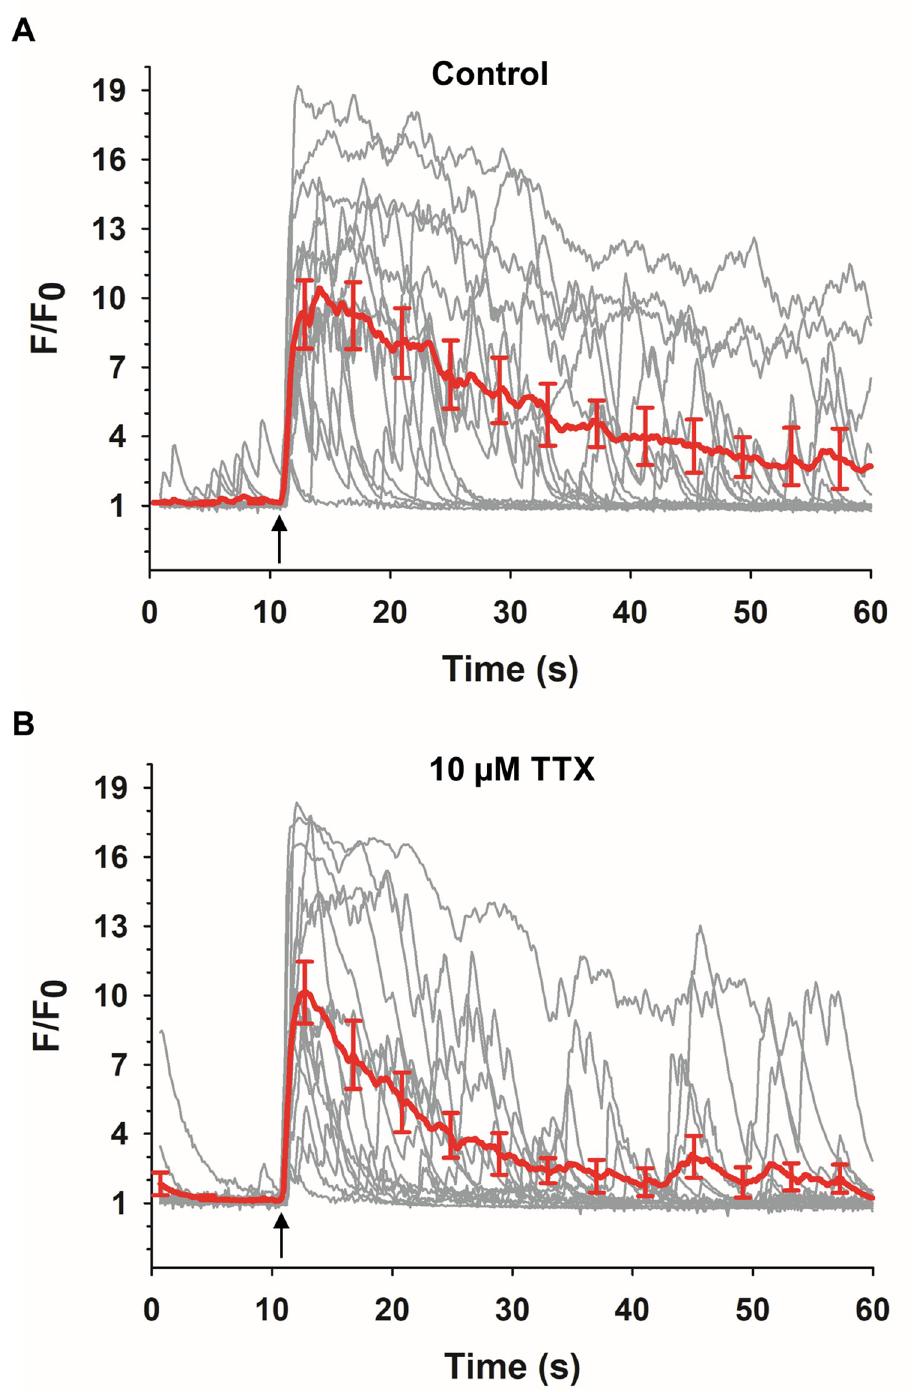
Fig 9. Effect of blocking VGSC with TTX on Ca 2+ responses evoked by a 5 ns pulse. Individual cell responses to a 5 ns pulse together with the averaged response ± SEM (red line), in mouse GCaMP6f-expressing ACC, in the absence (A; n = 3, c = 15) or presence (B; n = 3, c = 15) of 10 μ M tetrodotoxin (TTX). Cells in (A) and (B) are from the same 3 mice. Arrows indicate the times at which a 5 ns, 8 MV/m pulse was applied to the cells.